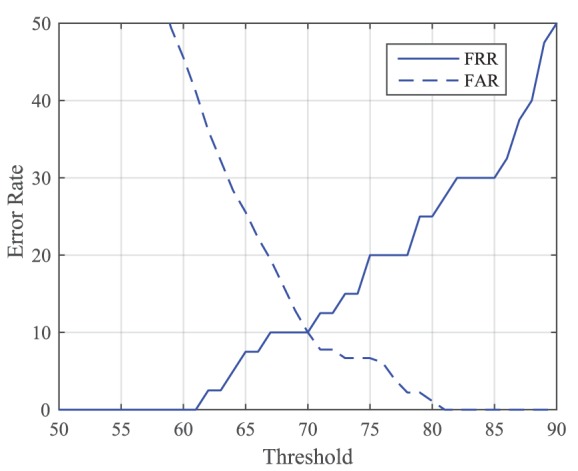
False rejection rate (FRR) and false acceptance rate (FAR) of synergy 1, when using all 10 joints. Equal error rate (EER) is calculated at the intersection of these plots. EER is 10% at a threshold of 70% correlation.